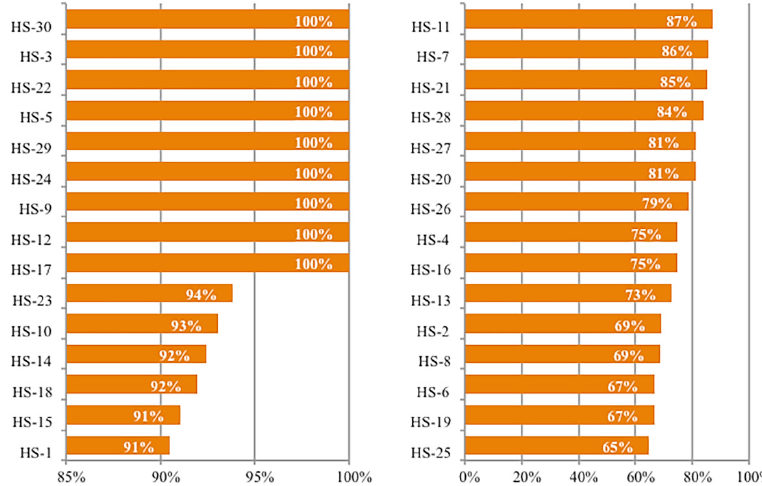
Fig. 2. Socio-economic efficiency